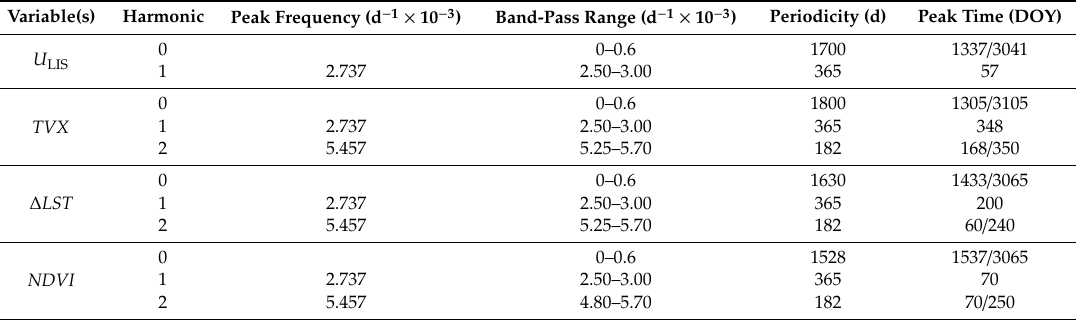
Table 1. Variables’ main harmonics: frequencies and times. For the harmonic “0” no peak frequency was reported since a zero-shift FFT algorithm was applied.